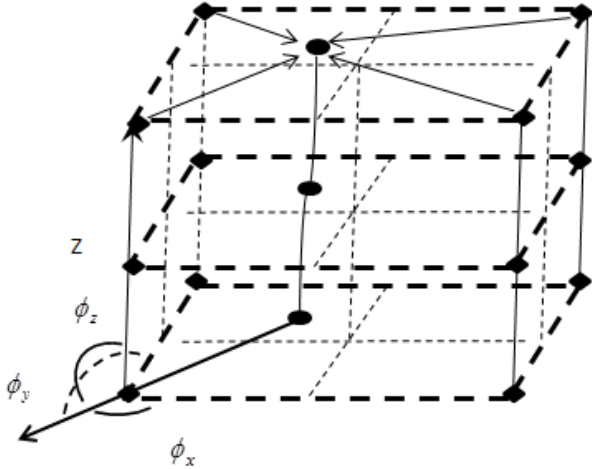
Fig. 2. Bilinear/spline interpolation: the rhomb points are the center of the voxels; the round points are the horizontal locations of ra- diosonde stations in different layers. In the horizontal the bilinear form with four adjoining points and in the vertical cubic splines are used for the